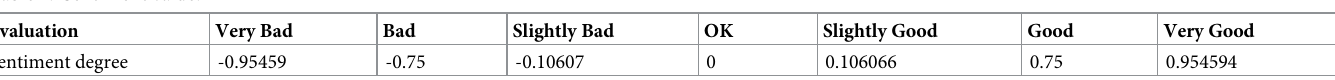
Table 1. Sentiment